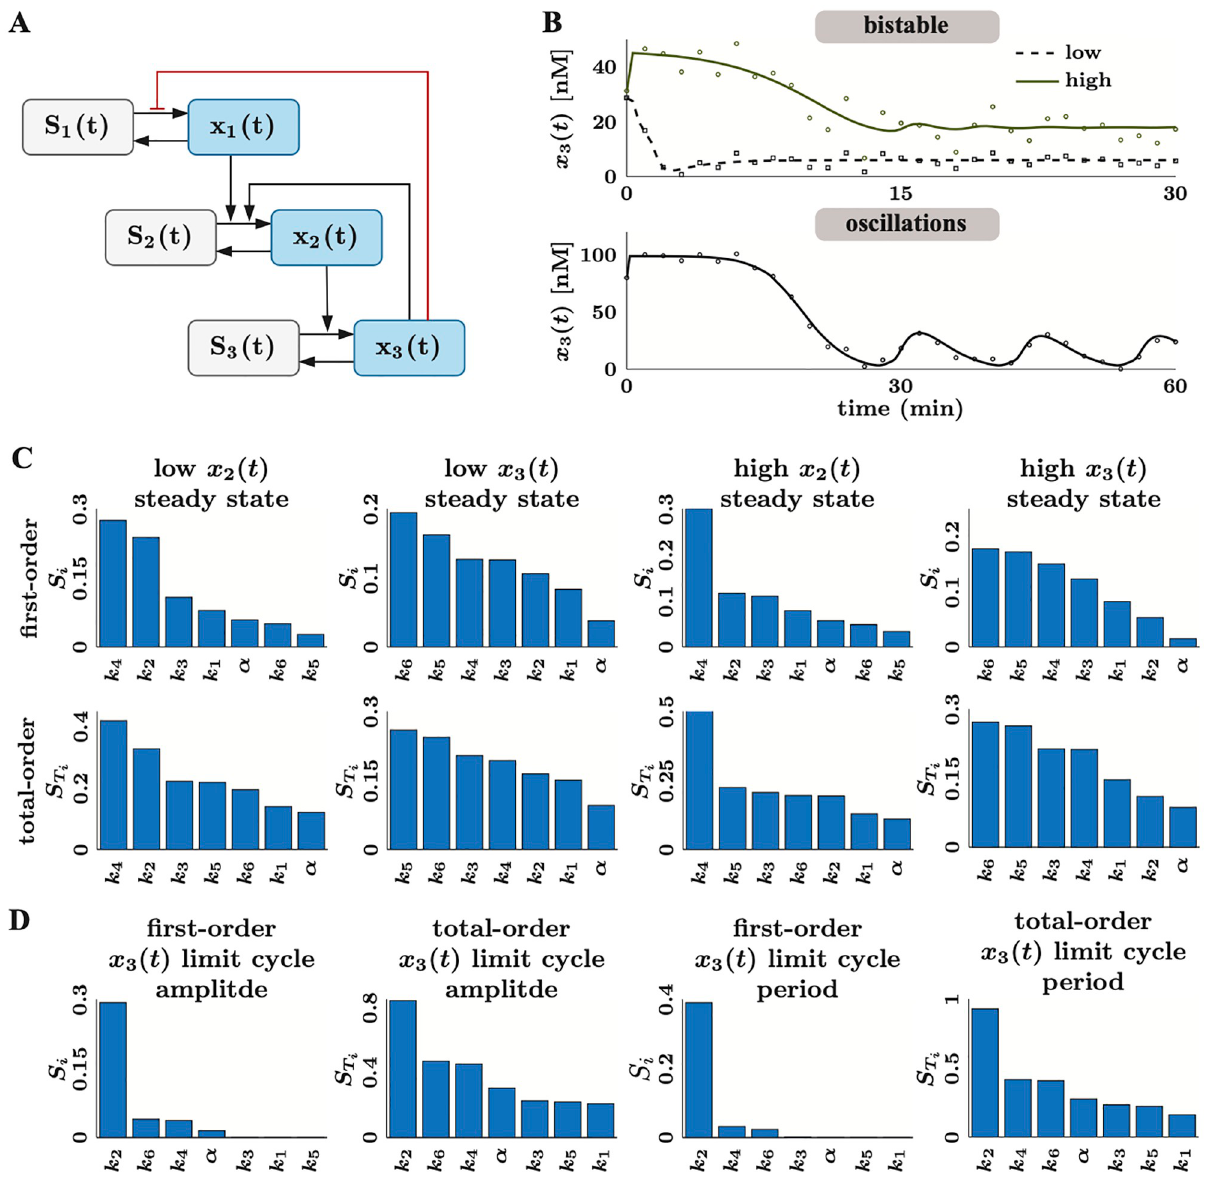
Fig 4. Parameter estimation for a simplified MAPK cascade that exhibits multistability. ( A ) Network diagram of the model of the core MAPK signaling cascade. The red line indicates inhibition; the black lines indicate activation. ( B ) Trajectories of x 3 ( t ) with the sets of nominal parameters that produce bistability (top) and limit cycle oscillations (bottom). The two dynamical regimes correspond to two different sets of nominal parameter values. The low (black dashed line) and high (solid green line) steady states are reached by manipulating the initial condition x 0 . The initial condition for the ¼ ½ 0 : 1245 ; 2 : 4870 ; 31 : 2623 � > and that for the low steady state is x ¼ ½ 0 : 0015 ; 3 : 6678 ; 28 : 7307 � > . ( C and D ) Sobol high steady state is x 0 ; high 0 ; low sensitivity for the MAPK model parameters. All parameters except the total concentrations, S 1 , S 2 and S 3 , exponents, n 1 and n 2 , and locally identifiable t t t K 1 and K 2 , are varied uniformly over the identified ranges (see S2 Table). We use 5,000 and 15,000 samples for the bistable and limit cycle regimes, respectively. ( C ) Sensitivity indices for bistable behavior dynamics. We use the steady state value of x 2 ( t ) and x 3 ( t ) for both the high and low steady states as quantities of interest. By selecting the two most sensitive parameters for the four quantities of interest, we reduce the set of free parameters to ¼ ½ k ; k ; k ; k � > . ( D ) Sobol sensitivity indices for a set of free parameters that contribute to limit cycle behavior. We show the first-order θ 2 4 5 6 f sensitivity indices S and the total-order indices S for the limit cycle amplitude and period of x 3 ( t ). We reduce the number of free parameters by i T i > 10 − 3 across both output quantities, that is, θ ¼ ½ k ; k ; k ; a � > selecting those with S i 2 6 4 f